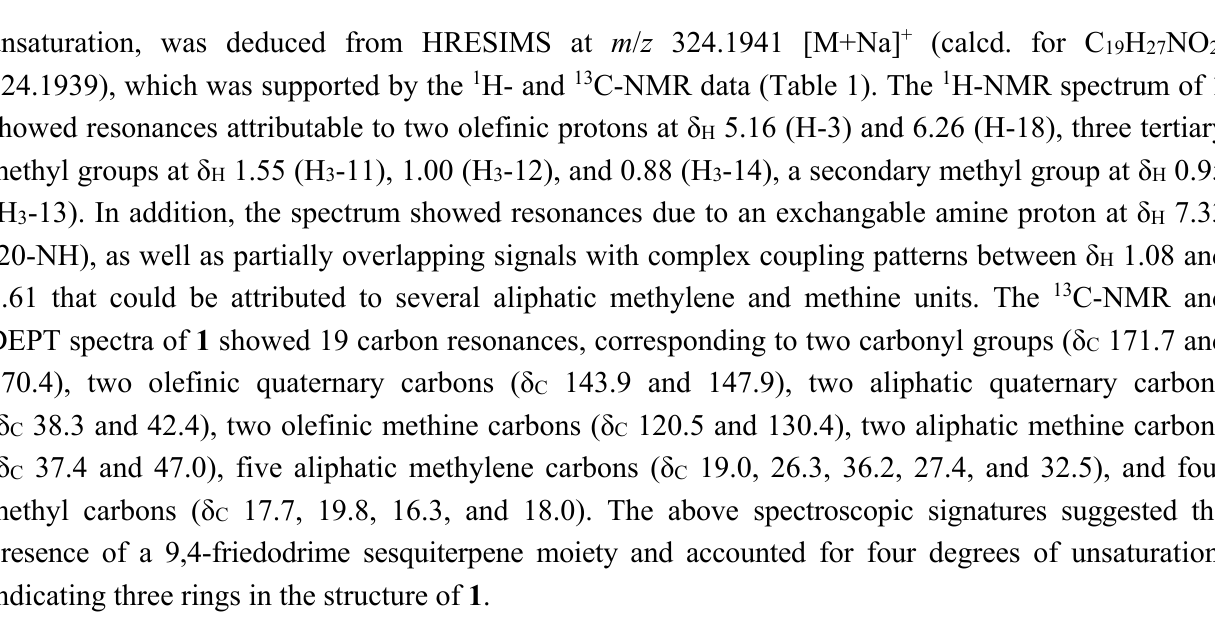
Table 1. The 1 H- (600 MHz) and 13 C- (150 MHz) NMR data of compound 1 in CDCl 3 . a